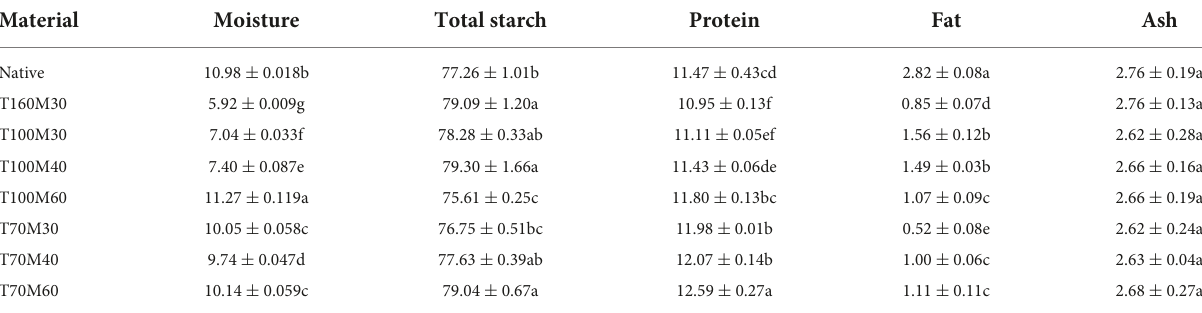
TABLE 2 Concentrations of moisture, total starch, protein, fat, and ash contents of native and pregelatinized Tartary buckwheat flour (g/100 g dry weight).